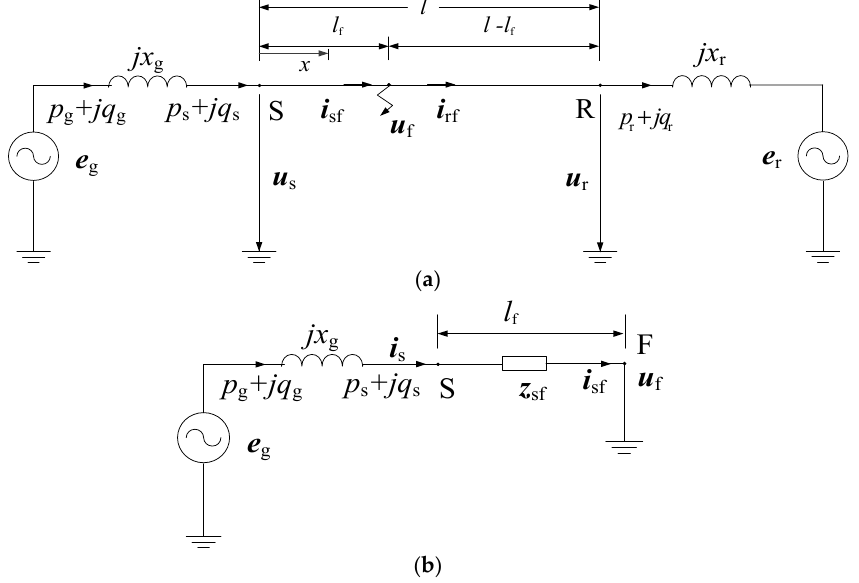
Figure 7. System model under the three-phase short circuit fault. ( a ) Schematic diagram of the fault location and related variables; ( b ) Sending end equivalent circuit under the fault.